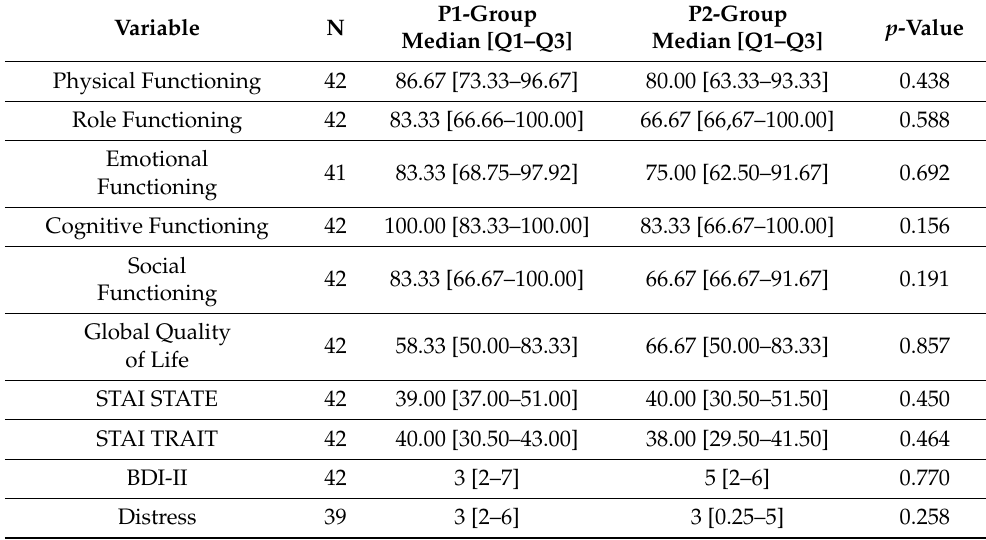
Table 3. Descriptive statistics of psychometric scales measured in the P1 and P2 groups and Mann- Whitney’s non-parametric U test for comparison between the two